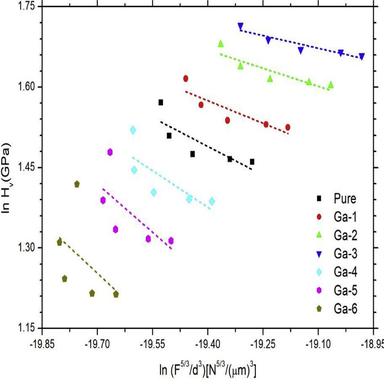
Differentiation of microhardness parameters, ln(Hv) as a function of indentation test load, ln(F5/3/d3 ) for all the materials prepared.